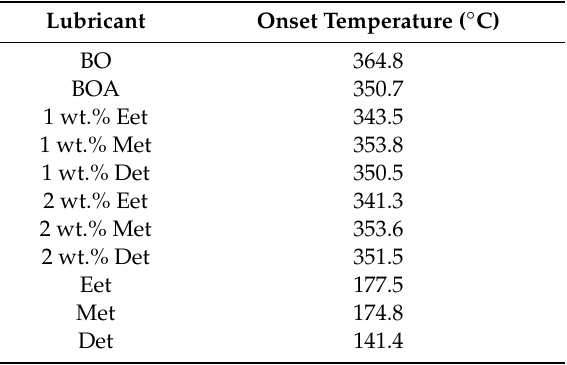
Table 5. Thermal stability of BO, BOA, neat PILs, and PIL blends.